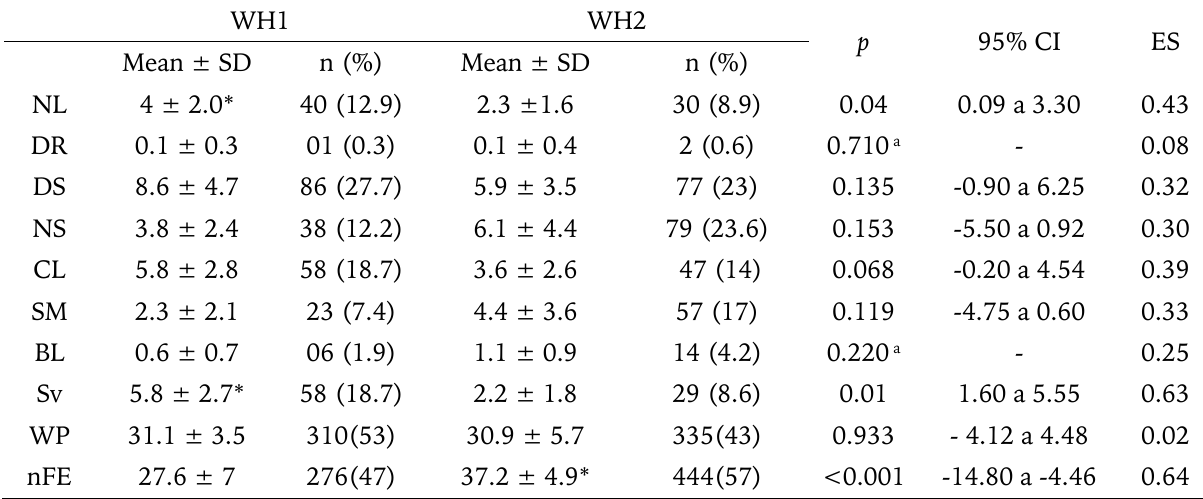
Number for several performance characteristics in the games of classes WH1 and WH2. Data are presented as mean and standard deviation, and as a total number (n) per class with percentage